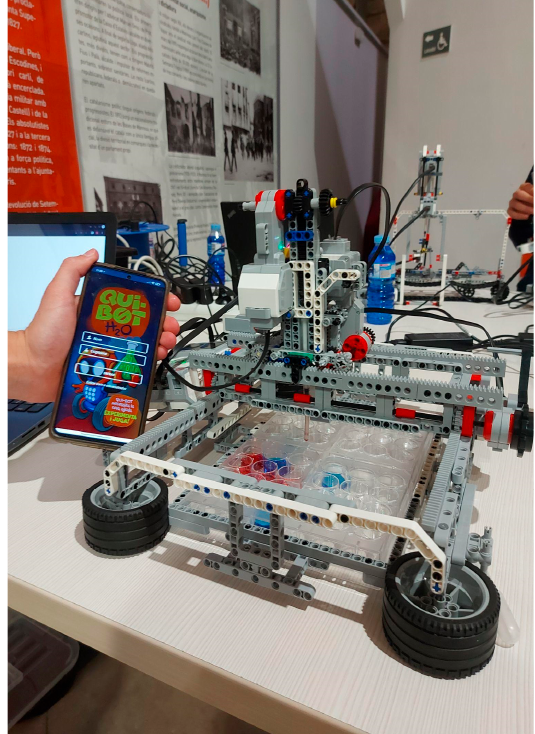
Figure 2. Lab-2D Qui-Bot app commanded [21].